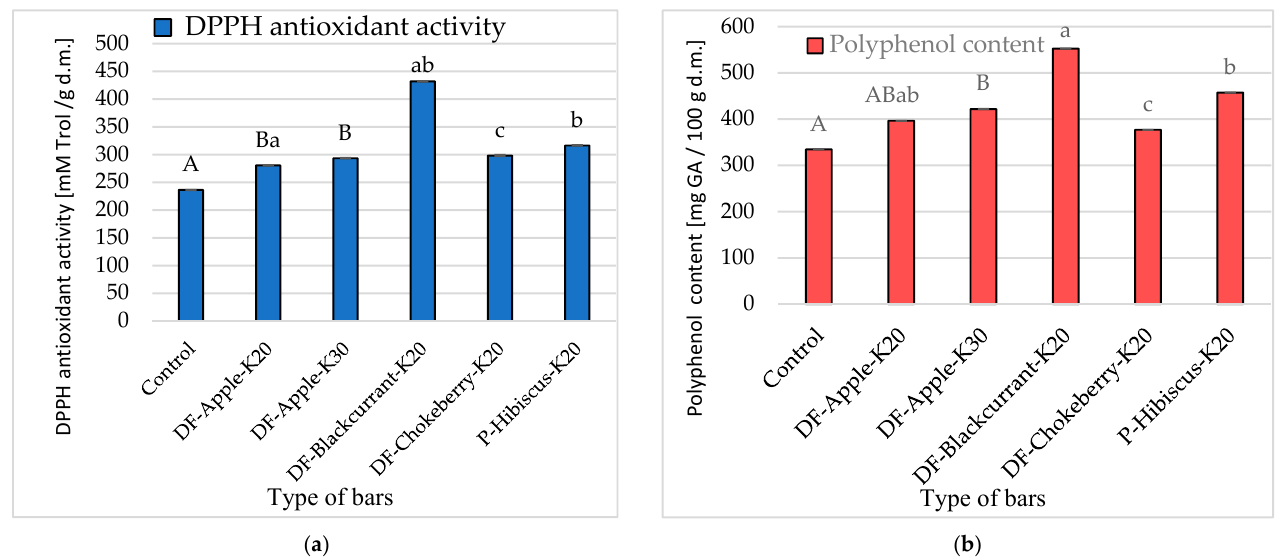
Figure 3. The influence of the kale (factor I) and fibre preparations (factor II) addition in multigrain bars on the: ( a )—DPPH antioxidant activity [mM Trol/ g d.m.] and ( b )—polyphenol content [mg GA/100 g d.m.]. Designations: A, B—homogeneous groups (factor I), and a, b, c—(factor II) at α = 0.05. The bar codes are explained in Table 4.